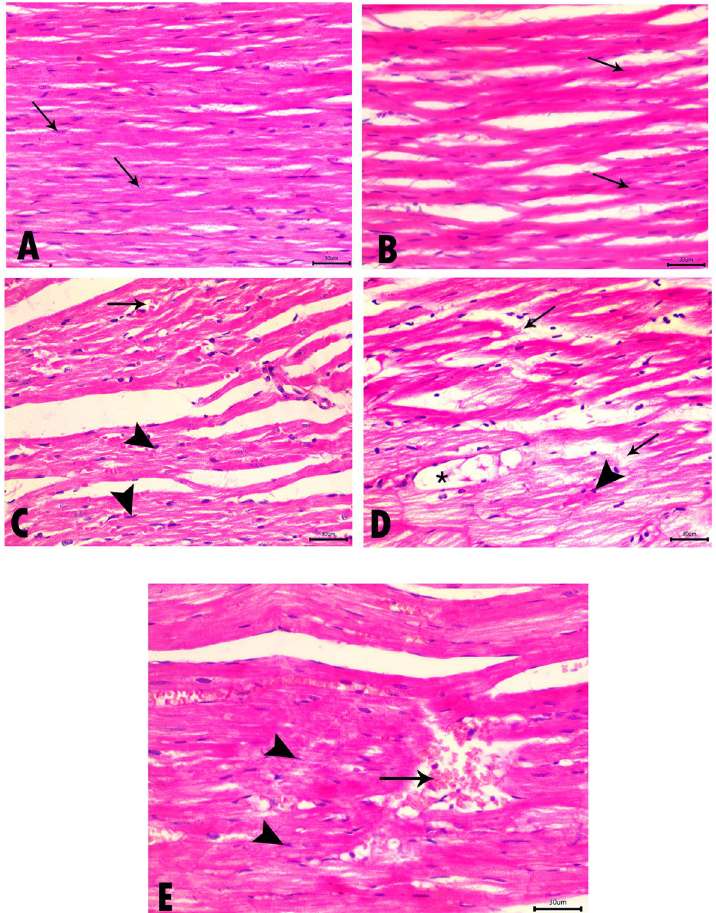
Fig. 11 Photomicrographs of the longitudinal sections of left ventricular heart muscles stained with H&E ( control groups show normal heart morphology with branching and anastomosing cardiac muscle fibers. Cardiomyocytes have acidophilic sarcoplasm and central vesicular nuclei (arrows). C Acute treated group showing disruption of some cardiac muscle fibers with congested blood vessels (arrow). Many deeply stained nuclei are also seen (arrowheads). D Chronic treated group showing disorganized cardiac muscle fibers with dilated blood vessels (asterisk). Degeneration and discontinuity of cardiac muscle fibers (arrows) with deeply stained irregular-shaped nuclei also appear (arrowhead). Mononuclear cell infiltration is also detected. E Chronic withdrawal group reveals dilated and congested blood vessels with disruption of cardiac muscle fibers and extravasation of blood cells (arrow). Degeneration and irregularly shaped nuclei are also detected